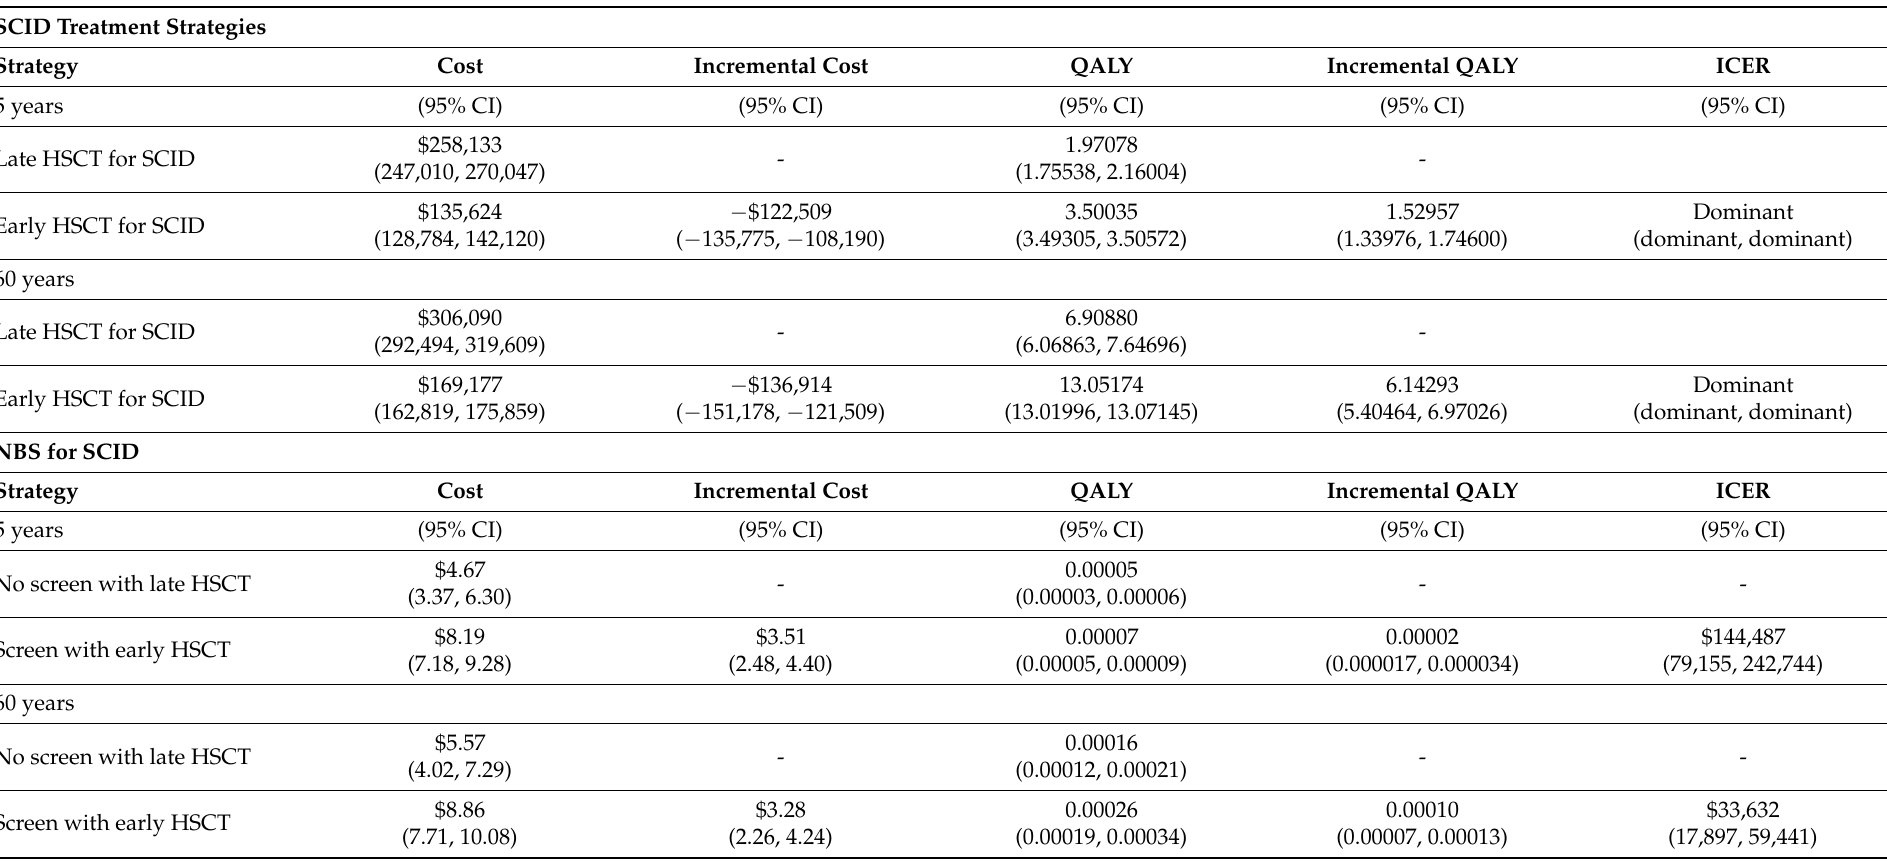
Table 3. Cost-effectiveness analysis of SCID treatment strategies and NBS for SCID, over 5 and 60 years from the government perspective, discounted 3% p.a. (US$